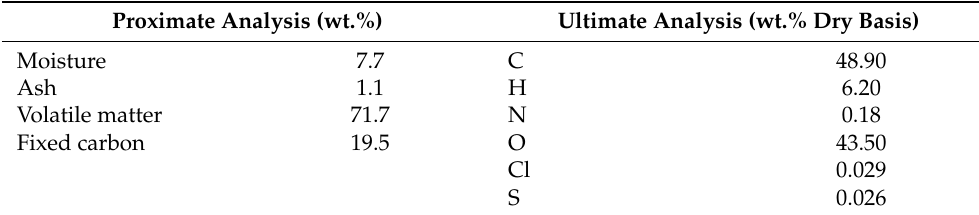
Table 1. Characterization of almond shells [38].